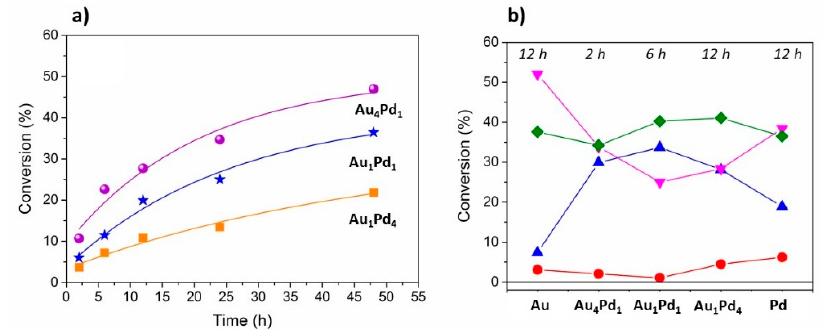
Figure 4. 5-hydroxymethylfurfural (HMF) oxidation in the aqueous phase in the absence of base using Au x Pd y @SiTi catalysts: conversion and selectivity as a function of time ( a ), and as a function of Au x Pd y composition at iso -conversion of 10% ( b ): selectivity to: ● 2-, 5-furandicarboxylic acid (FDCA), ▲ 2, 5-diformylfuran (FDC), ▼ 5-hydroxymethyl-2-furancarboxylic acid HFCA, 5-formyl-2-furancaboxylic acid (FFCA). Aqueous solution of HMF (30 µmol), substrate/metal = 18 (mol/mol), O 2 (1 bar), 100 °C, 600 rpm.